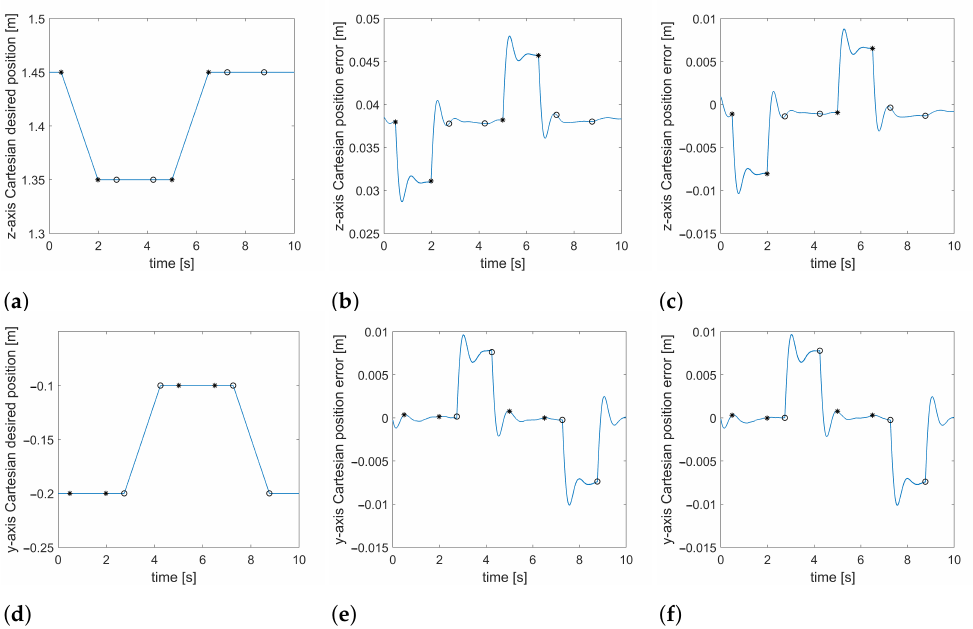
Figure 11. Experiments in simulation. The plots from control in Cartesian impedance mode with the grasped 2 kg object: ( a , d ) the Cartesian desired positions, ( b , e ) the errors with no compensation, ( c , f ) the errors with object weight compensation. The upper and lower rows concern the z -axis and y -axis, respectively.